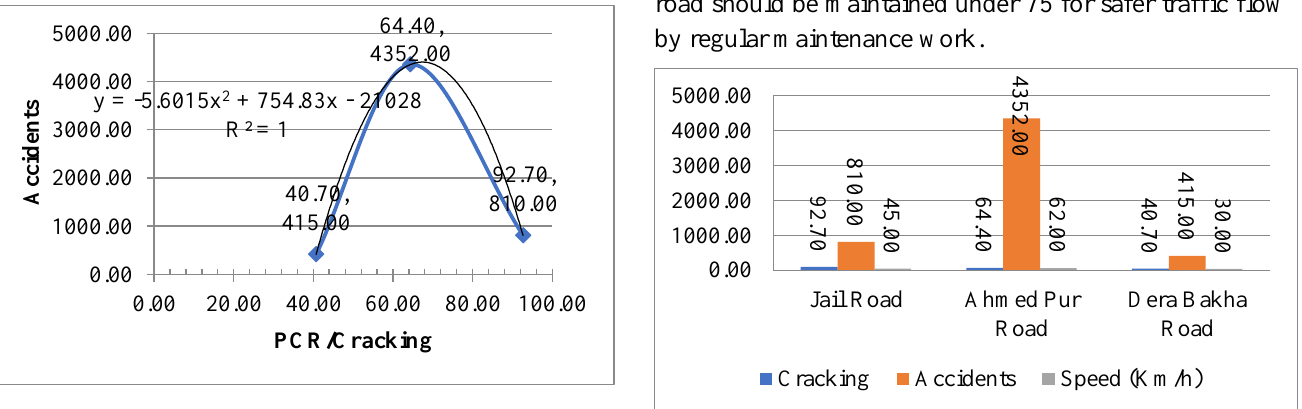
Fig. 15. PCR vs. accident data